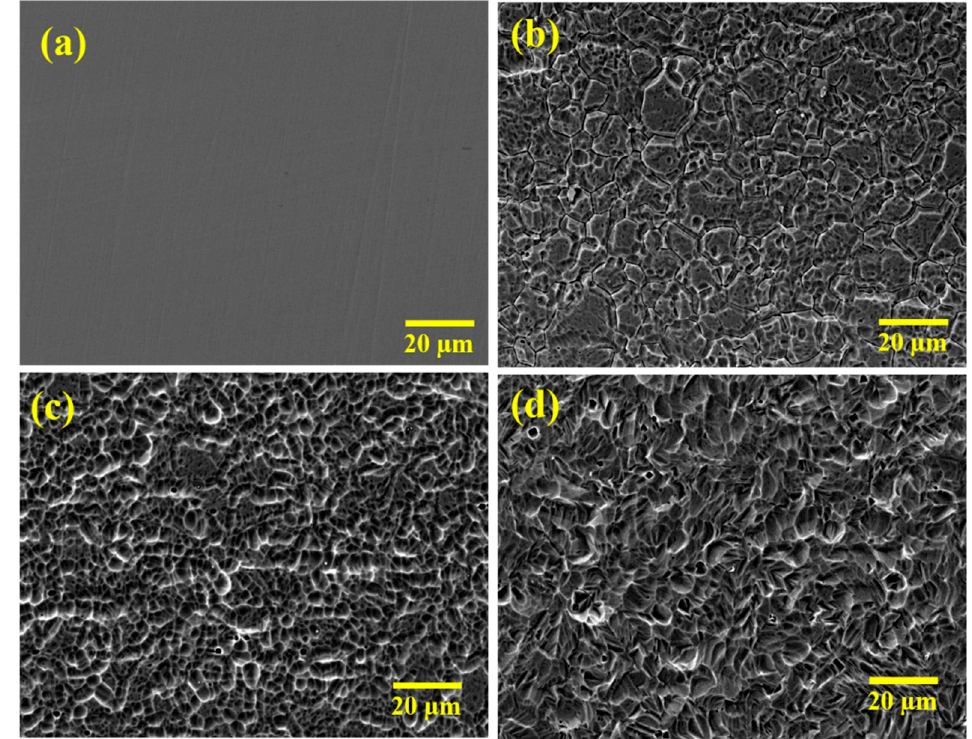
Figure 1. SEM images of untreated and treated 316L SS specimens ( a ) Bare, ( b ) EP2.5V, ( c ) EP5.0V, and ( d ) EP7.5V.